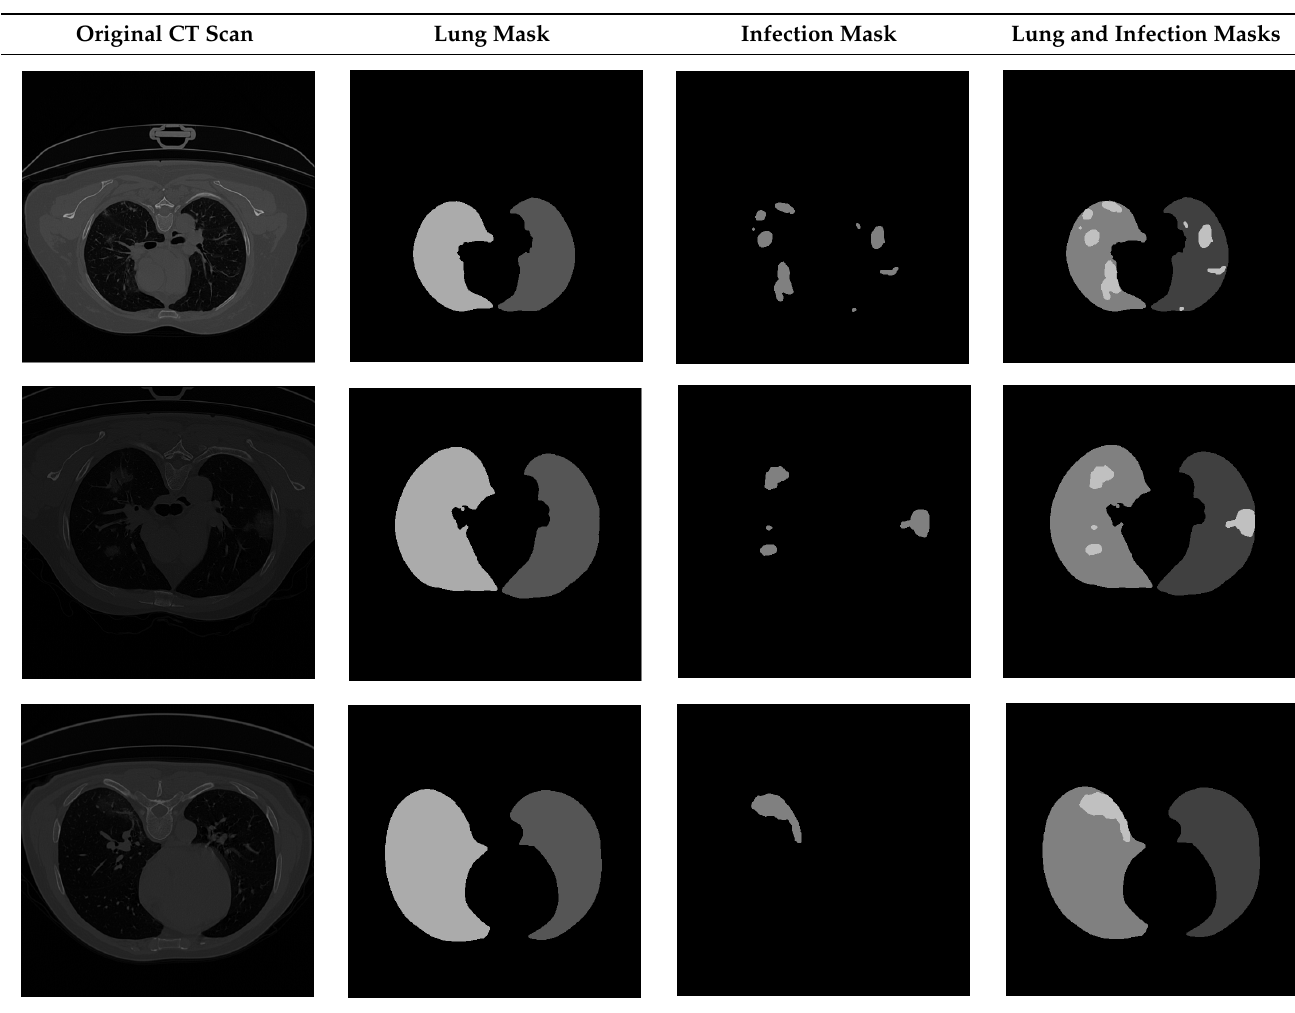
Table 2. Three sample images from the used dataset. First column: original CT scans. Second column: lung masks. Third column: infection masks. Fourth column: superposition of the lung and infection masks.